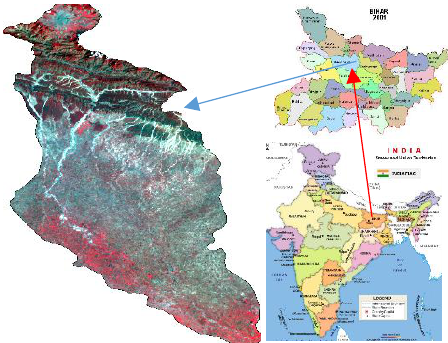
Figure 1.1. FCC map of Bagmati river basin with location map (Sources: NRSC and Maps of India) In its 3 rd reach from Kalanjarghat to Hayaghat its not embanked. In its last reach from Hayaghat to Khormaghat the left bank is embanked from Hayaghat to Phuhia and the right bank is the study area is from 26 o 02’N and 85 o 15’E to 26 o 46”N and 85 o 45’E, i.e., from Dheng railway bridge to Benibad is used for 1-D HD modelling and flood inundation mapping.